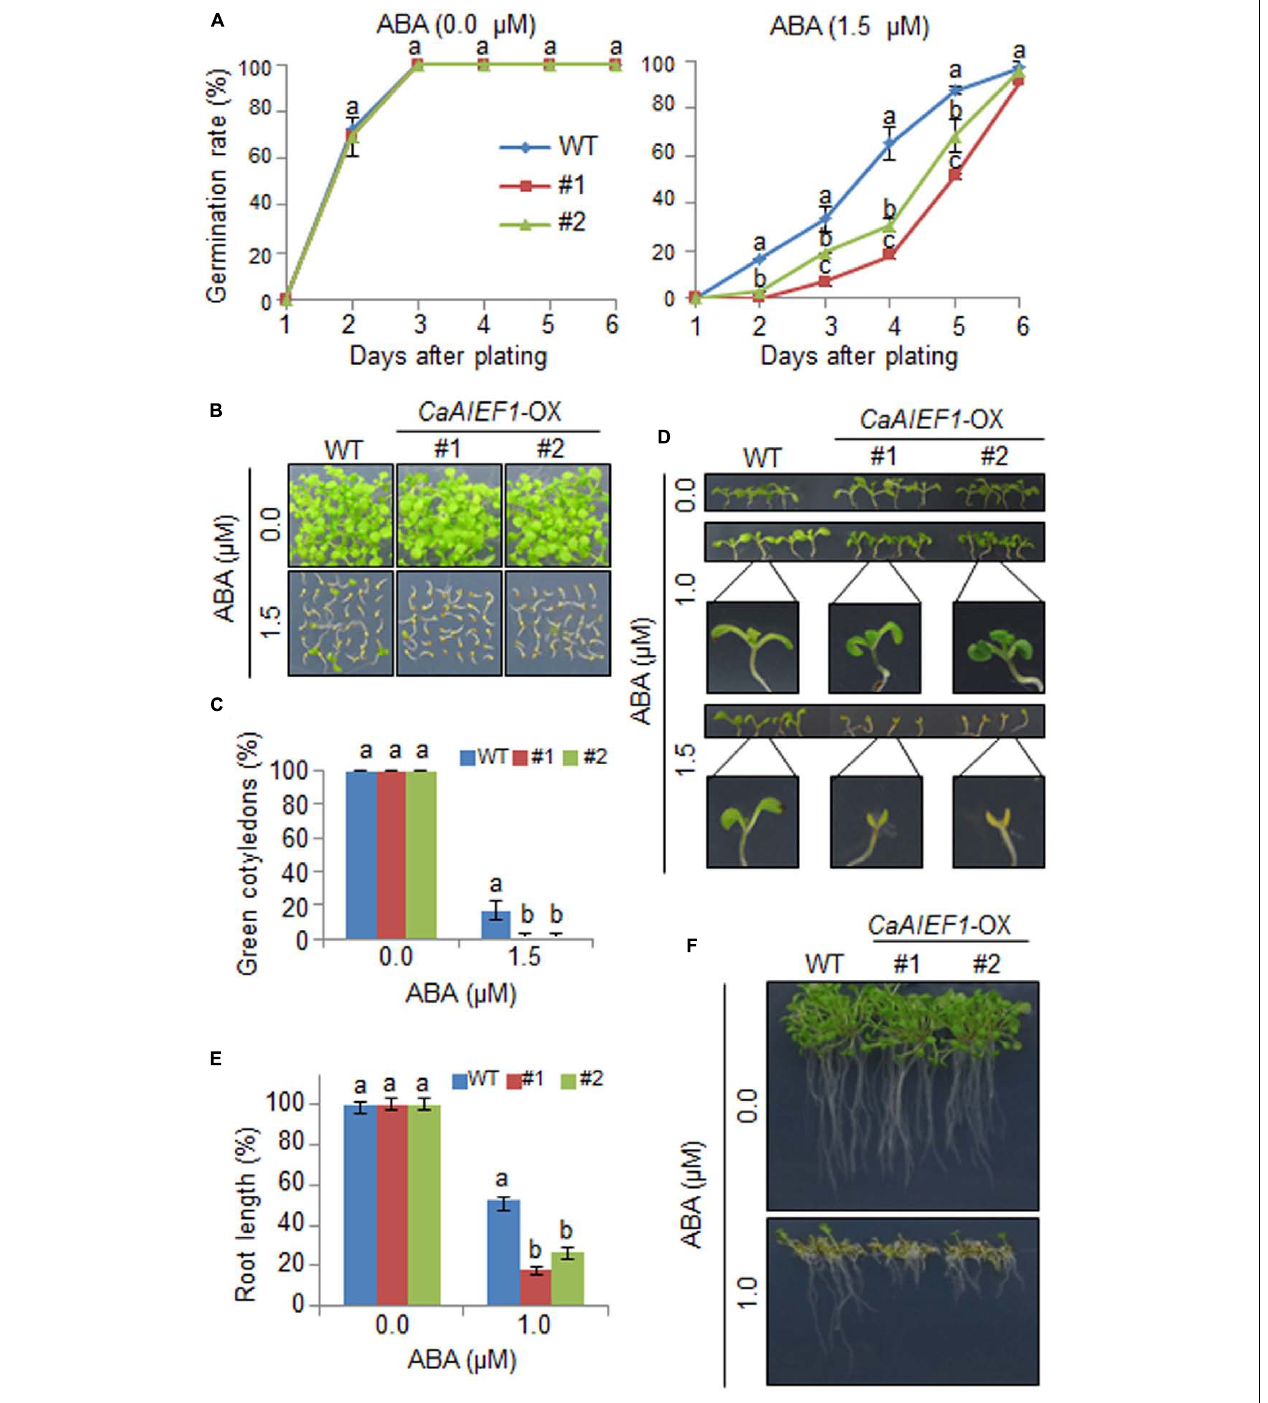
FIGURE 4 | Increased sensitivity of CaAIEF1- overexpressing (OX) transgenic Arabidopsis plants to ABA during germination and seedling growth. (A) Seed germination of wild-type (WT) and transgenic lines in response to ABA. Seeds were germinated on 0.5 × Murashige and Skoog (MS) agar plates containing 0.0 µ M or 1.5 µ M ABA. Data represent the mean ± standard error values obtained after evaluating 150 seeds from three independent experiments. (B–D) Growth of WT and transgenic seedlings on 0.5 × MS agar plates containing various concentrations of ABA. Representative photographs were taken 12 days after plating (B,C) . Quantification of green cotyledons in the wild-type and each mutant line was performed 12 days after plating (D) . Data represent the mean ± standard error values obtained after evaluating 72 seeds from three independent experiments. (E,F) Root elongation of WT and transgenic plants in response to ABA. The root length of each plant was measured 9 days after plating. Data represent the mean ± standard error of three independent experiments. Different letters indicate significant differences (ANOVA; P < 0.05).